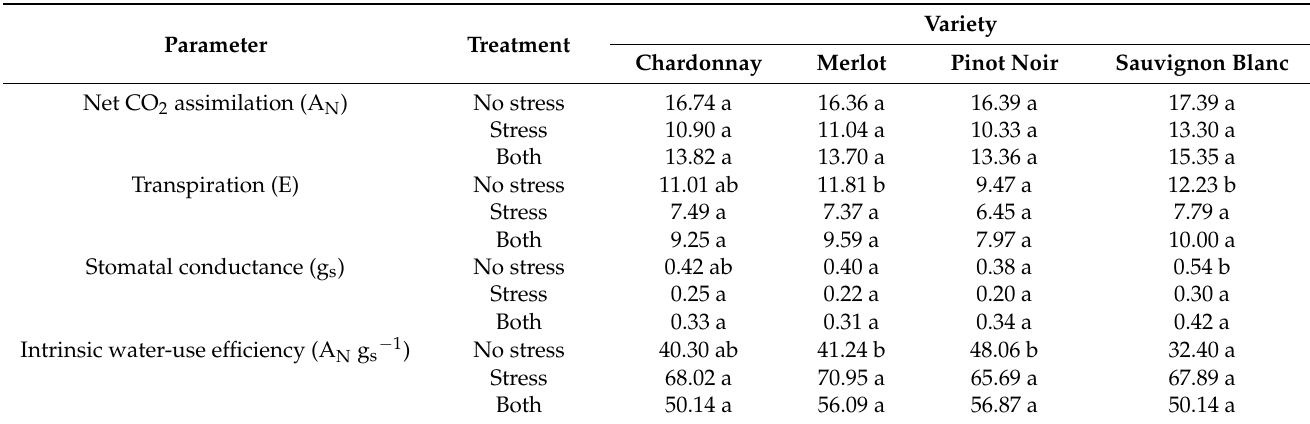
Table 3. Gas exchange variables and intrinsic water-use efficiency obtained in leaves from five different grapevine varieties under stress and no stress